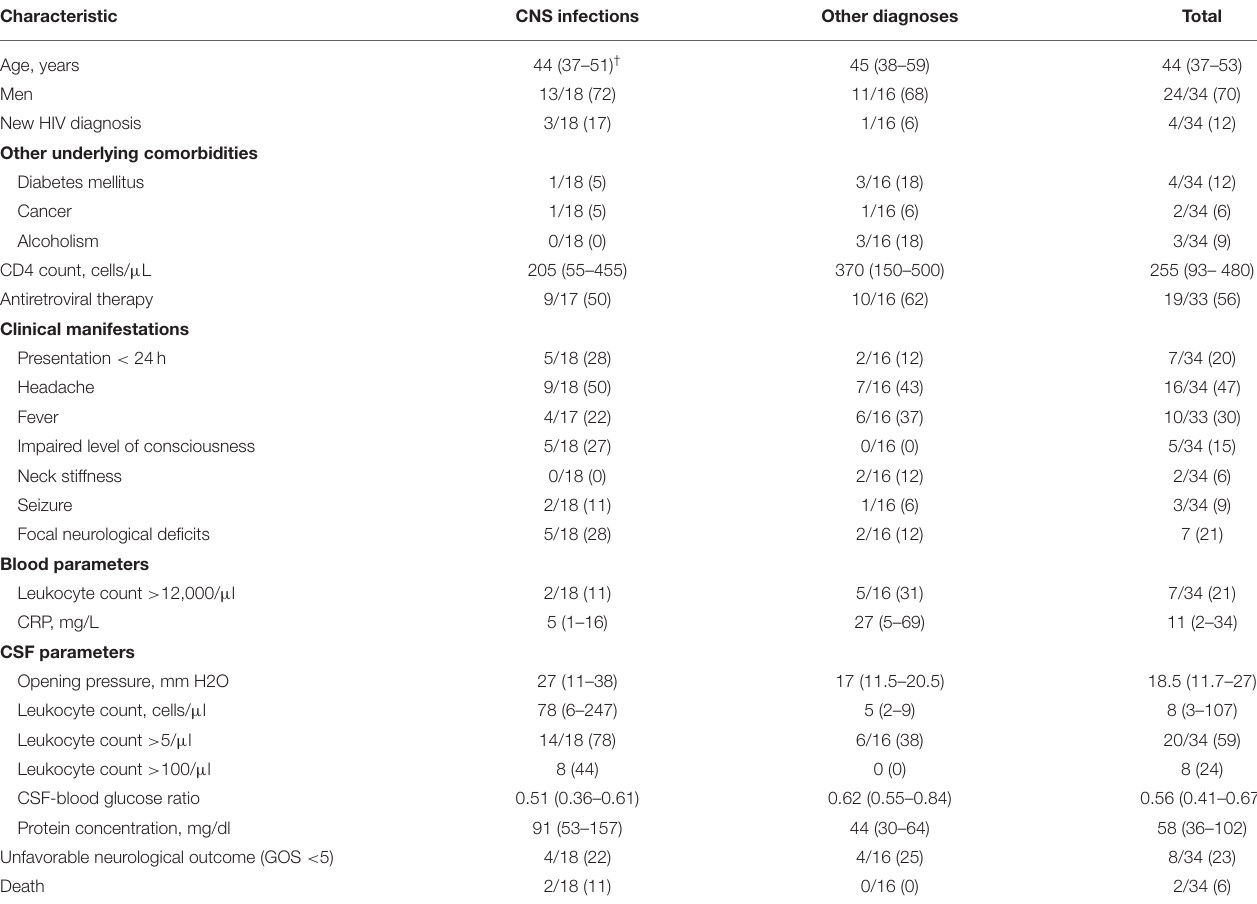
TABLE 1 | Characteristics of 34 HIV-infected patients with suspected central nervous system infection.